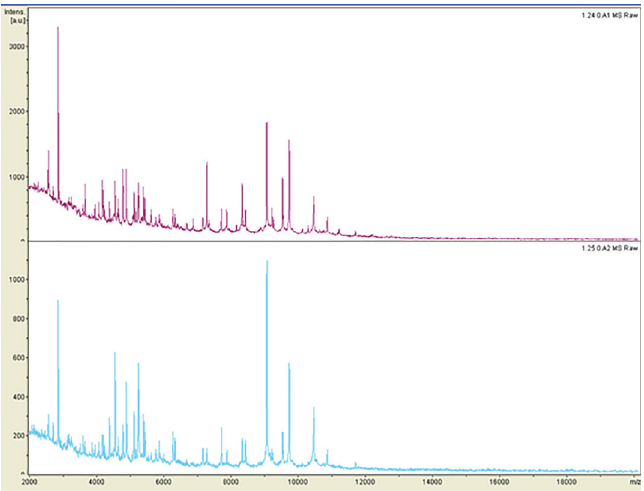
Figure 5 - Mass spectra of E.Coli isolated from urine from the category "isolates before the experiment/ isolates after the experiment".